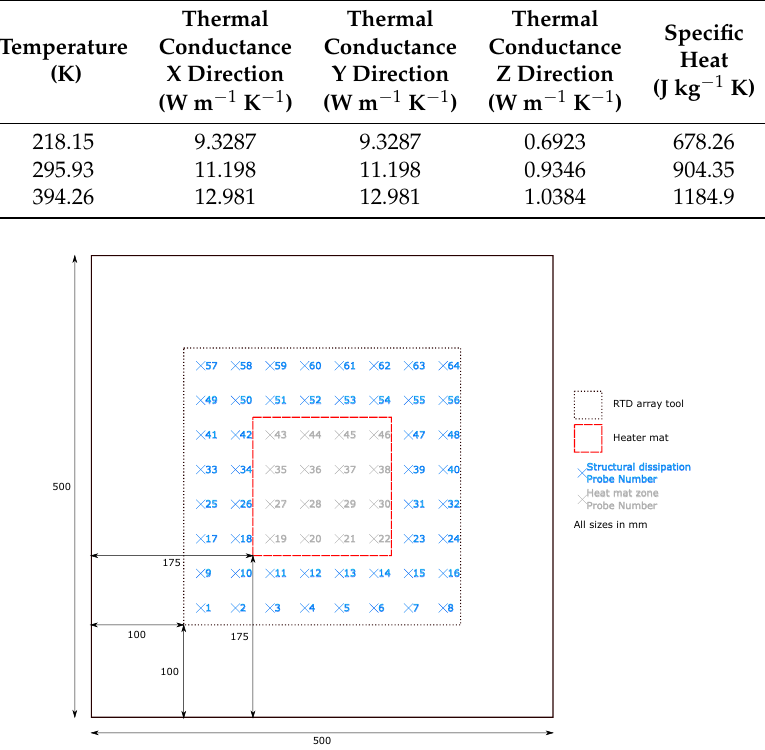
Figure 1. The 500 by 500 mm sample panel data capture set up with 150 mm × 150 mm heat zone (dashed red) and 300 by 300 mm RTD probe array (dashed black).